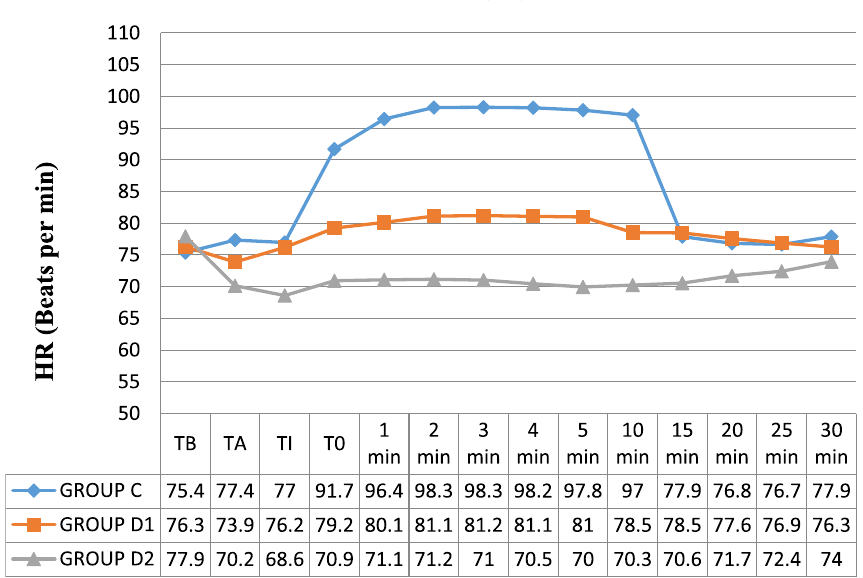
Fig. 2 Comparison of mean HR among three